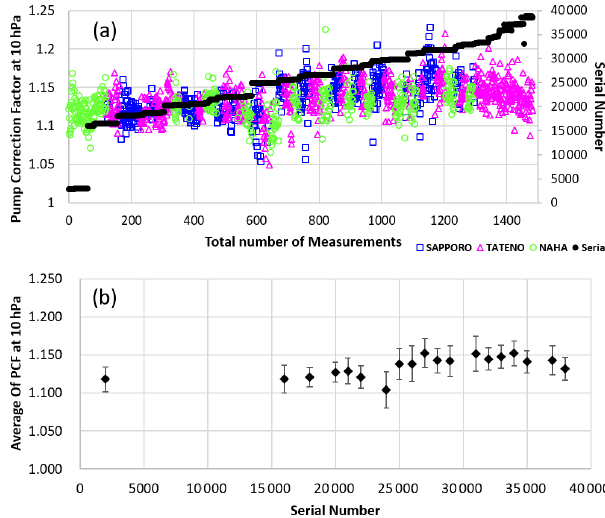
Figure 15. (a) Pump correction factors at 10hPa from 2009 to 2022 sorted by ozone sensor serial number. (b) The same averaged for each bin of 1000 ozonesonde serial numbers for 2009 to 2022. Error bars represent standard